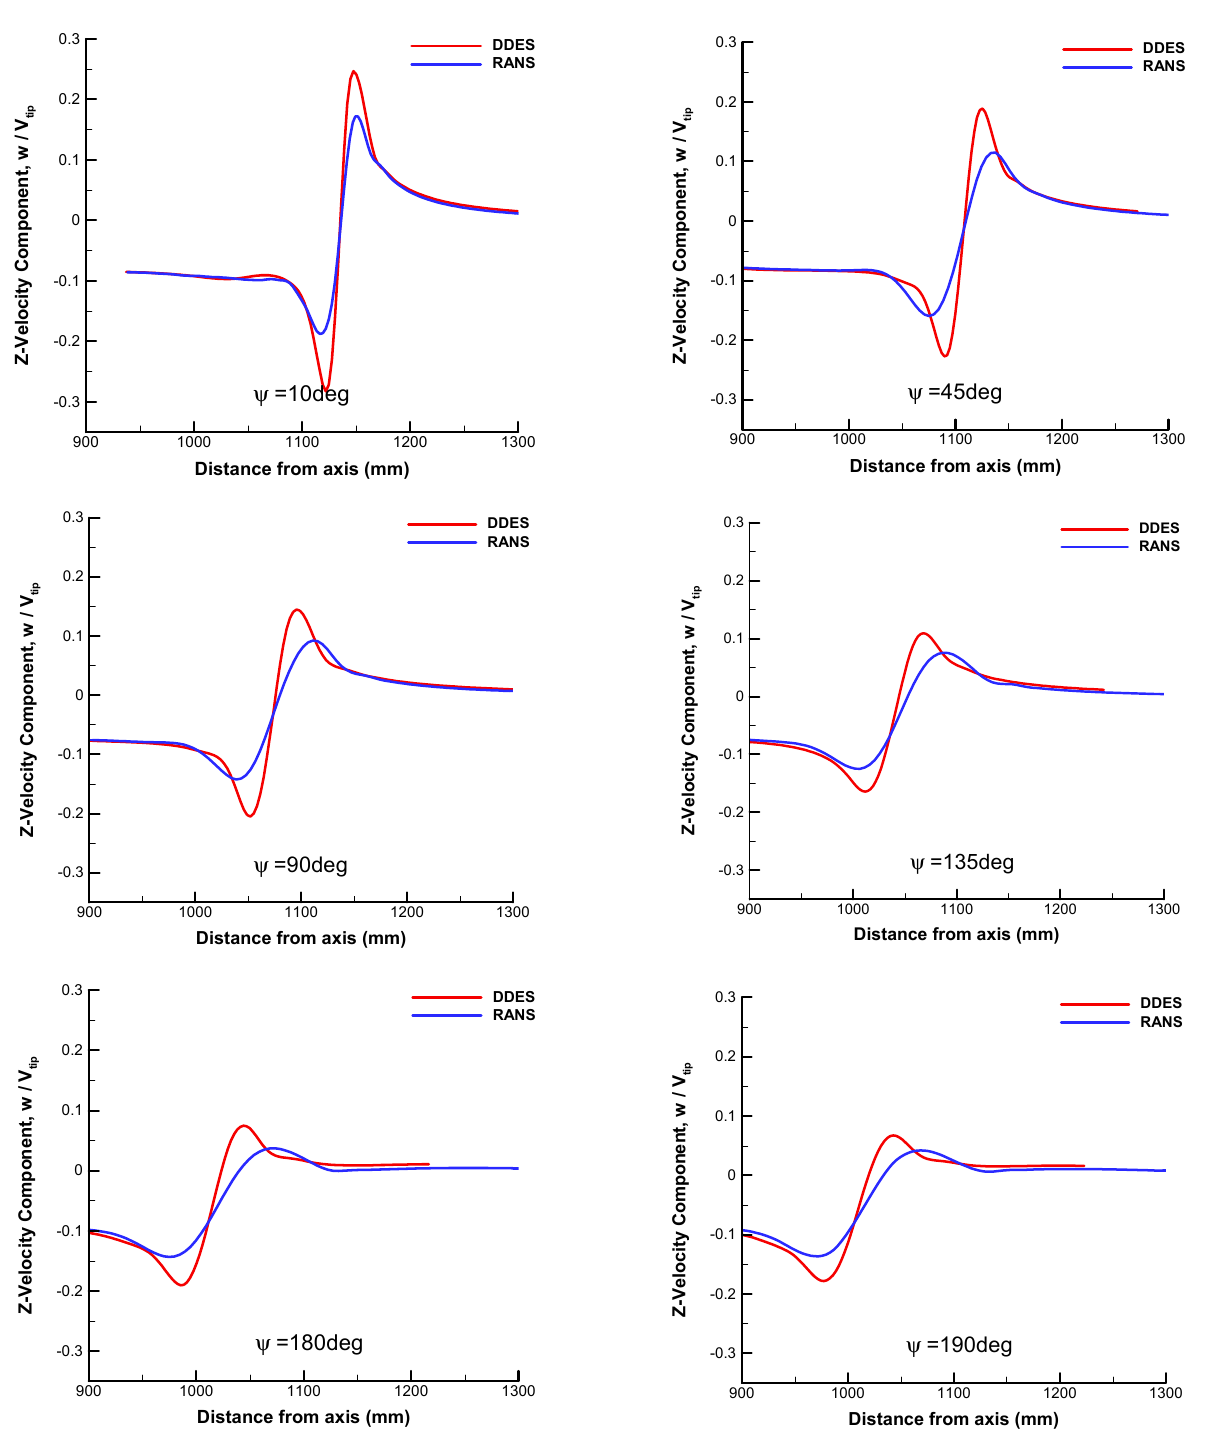
Figure 17. Comparisons of velocity profiles at comparable wake ages.